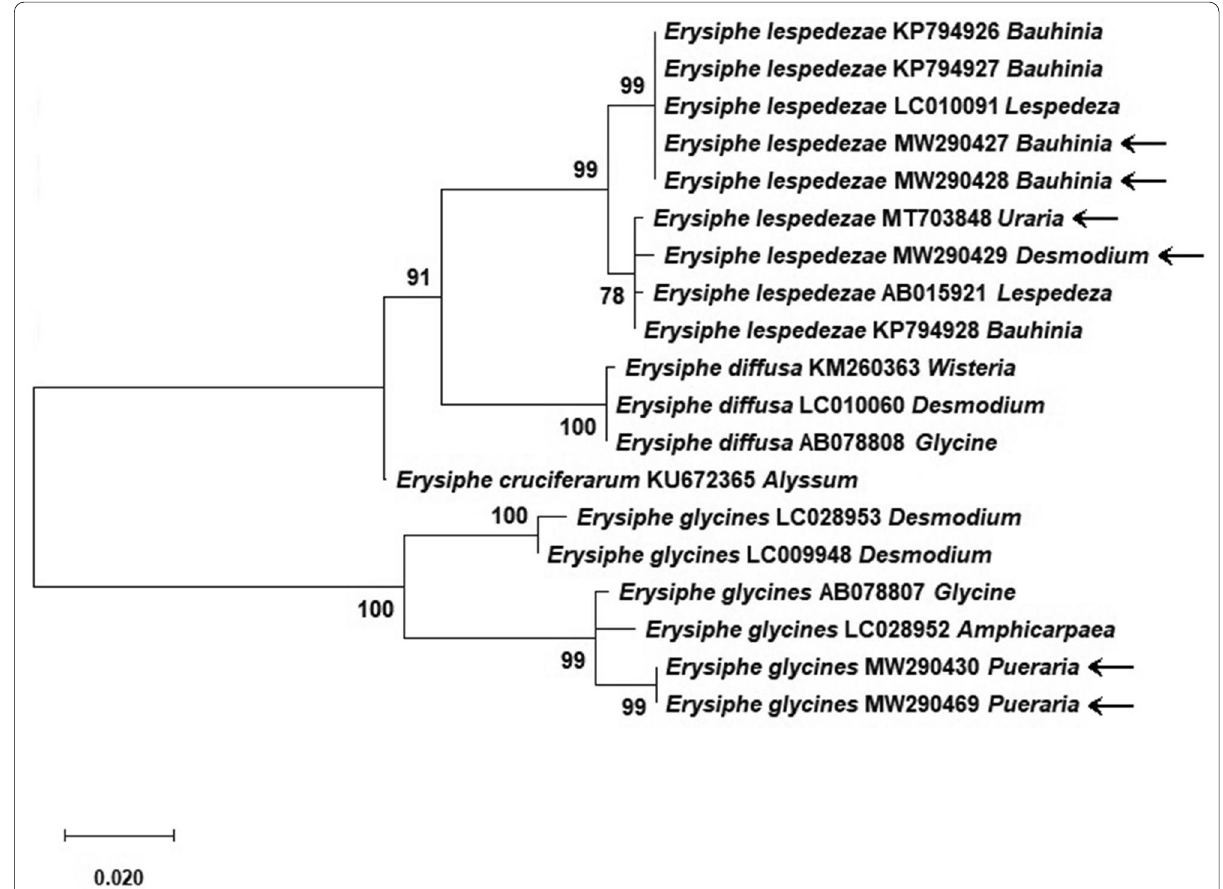
Fig. 1 Maximum likelihood analysis of ITS sequences of selected Erysiphales indicating the identification of specimens on medicinally used Fabaceae from Taiwan. Bootstrap values of 1000 replicates above 50% shown. Scientific name of powdery mildew followed by GenBank number and host genus name (new sequences indicated with